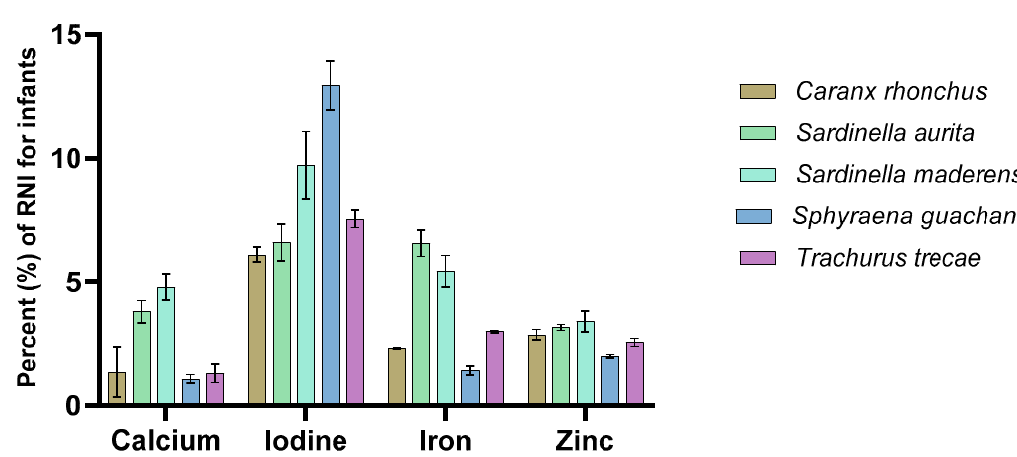
Figure 2. The contribution of calcium, iodine, iron, and zinc (in percentage) to the recommended nutrient intake (RNI) for infants during the first 1000 days of life, from the consumption of a 25 g portion fillet of the various fish species.